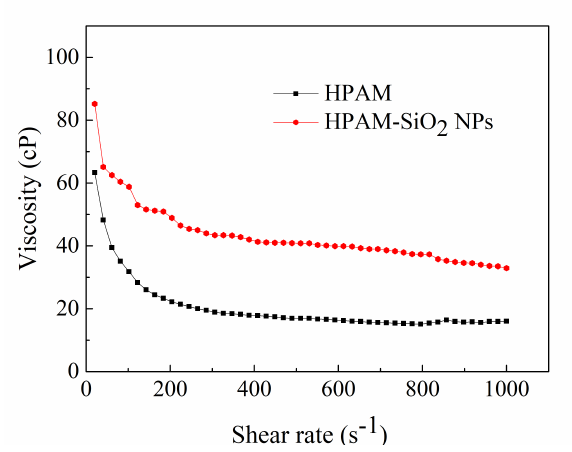
Fig. 9. Shear viscosity of HPAM and HPAM-SiO 2 NPs at 60,000ppm